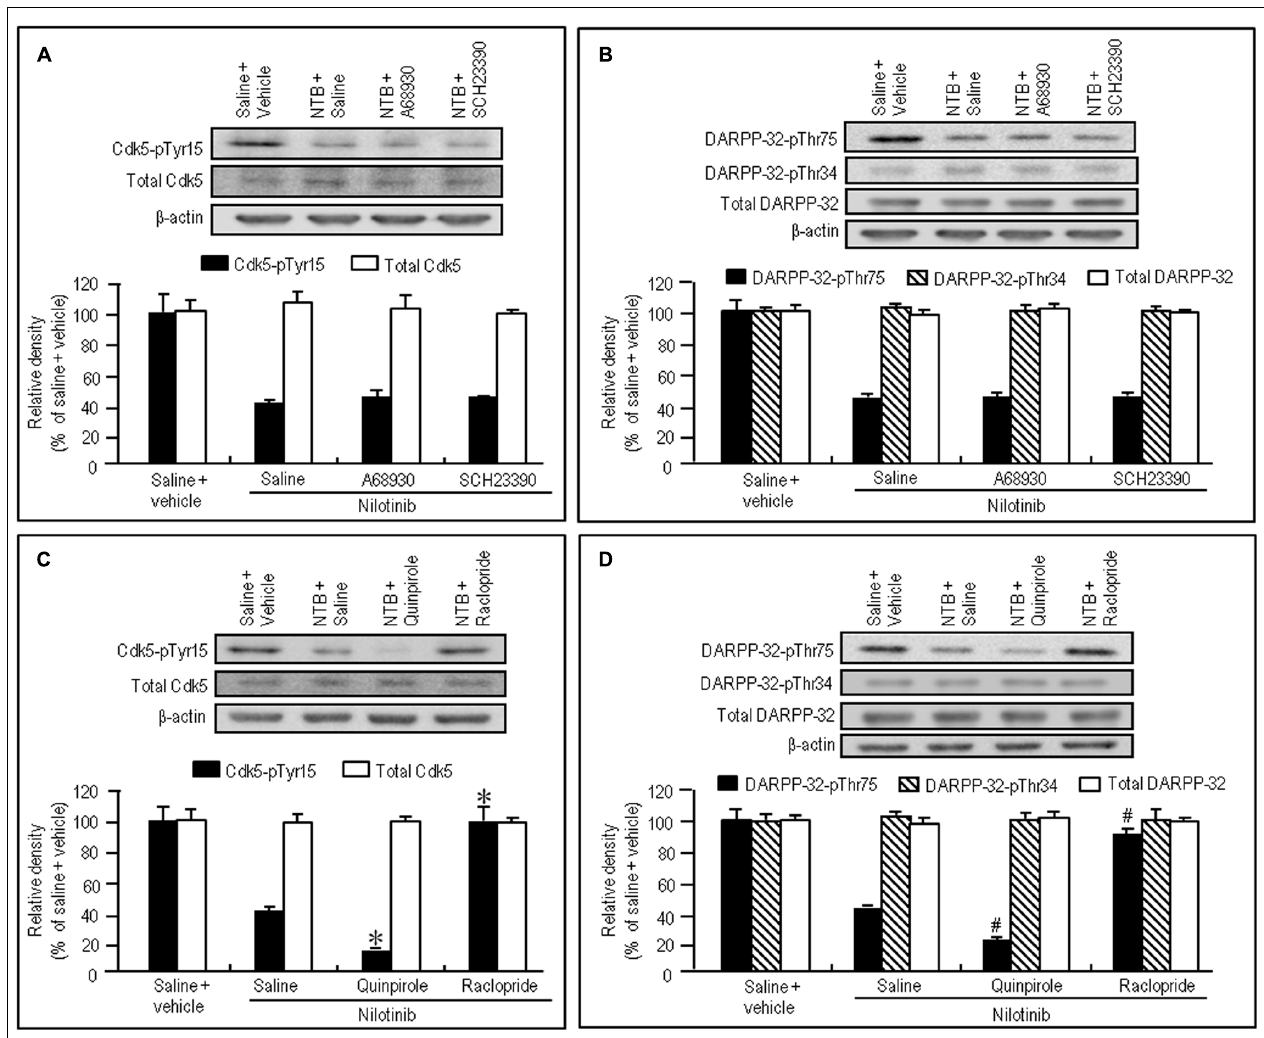
FIGURE 3 | Dopaminergic modulation of nilotinib effects on striatal phosphorylation ofTyr15-Cdk5 andThr75-DARPP-32 in naïve mice. Vehicle or nilotinib (NTB; 25 mg/kg) treated mice were administered saline, A-68930 (2 mg/kg), SCH-23390 (0.5 mg/kg), quinpirole (3 mg/kg), or raclopride (1 mg/kg) 30 min before sacrifice. Striatal tissue extracts were prepared and subjected to western blotting. (A) Western blot analysis of striatal levels of Cdk5-pTyr15 and total Cdk5 in mice treated with saline + vehicle, NTB + saline, NTB + A-68930, or NTB + SCH-23390.Values are means ± SEM ( n = 5). (B) Western blot analysis of striatal levels of DARPP-32-pThr75, DARPP-32-pThr34, and total DARPP-32 in mice treated